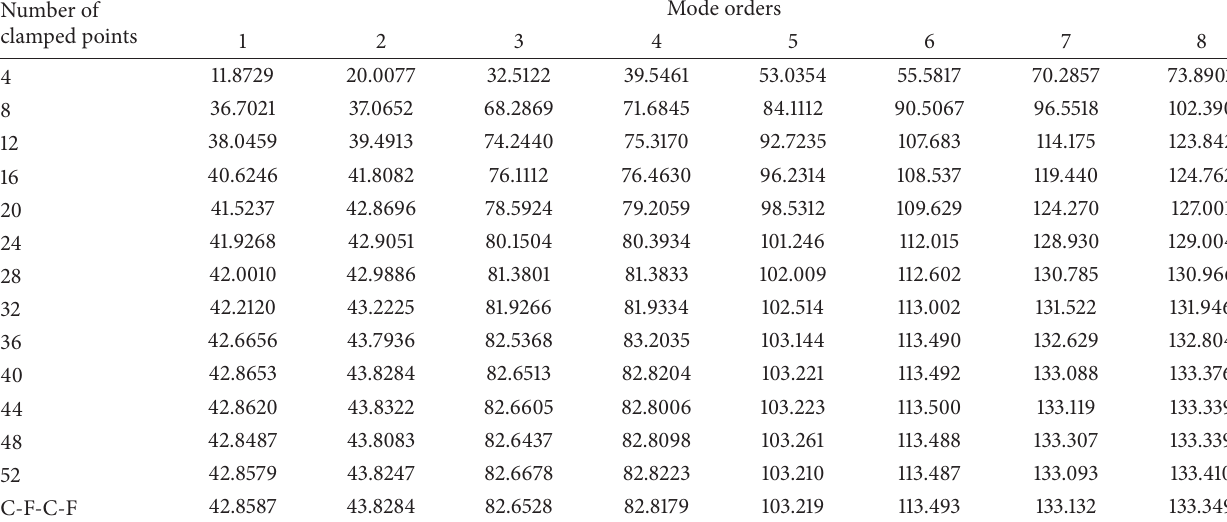
Table 10: First eight frequencies (Hz) for an open conical shell with multipoints clamped-supported at the edges 𝛼 = 0 and 𝛼 = 𝐿 𝛼 . Number of clamped